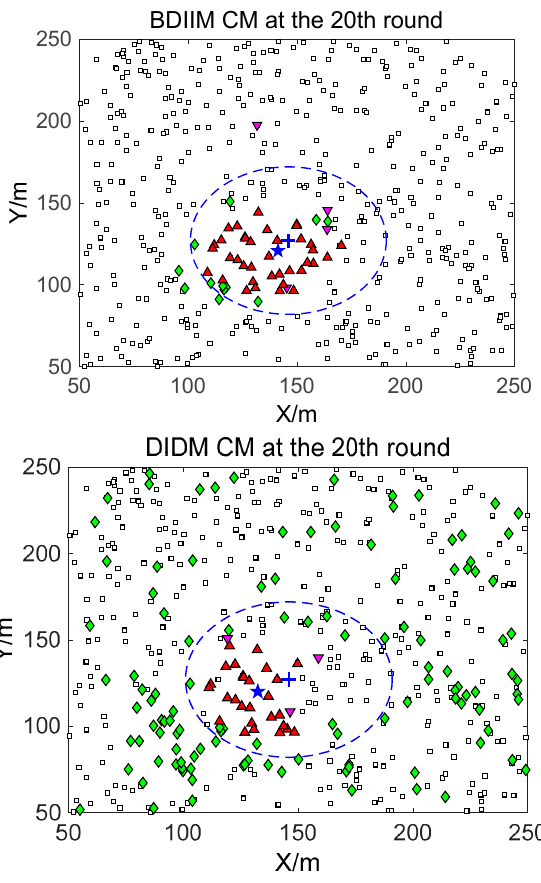
Figure 9. The state of the CM at the 20th time interval.